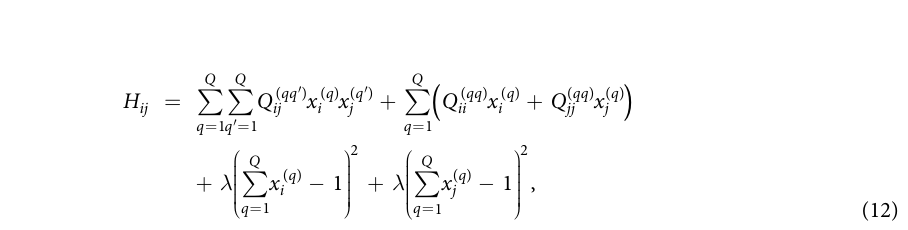
Table 4. Average number of feasible solutions in an embedded subproblem: log 10 N feasible